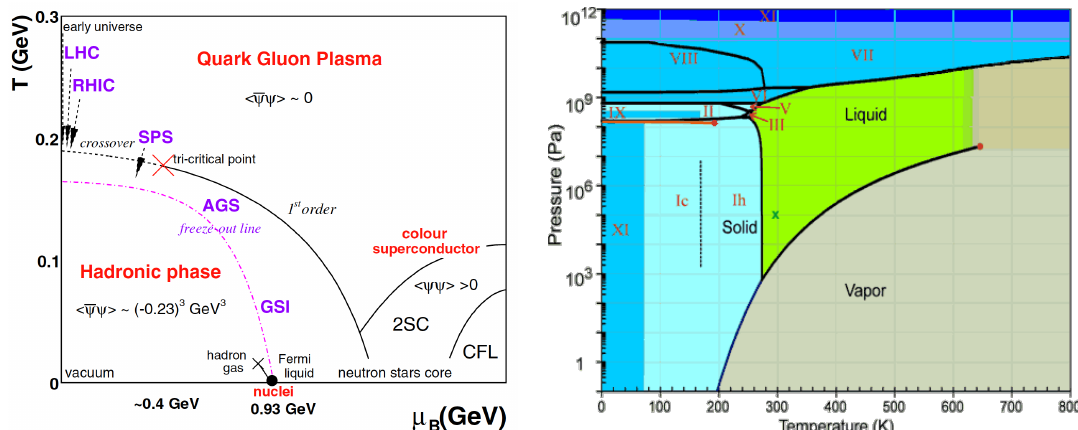
Figure 1. Left : The schematic phase diagram of quantum chromodynamics (QCD) in terms of T and µ B state variables adapted from Ref. [71]; Right : The phase diagram of water illustrates a similar complexity, and is taken from Ref. [72]. AGS: Alternating Gradient Synchrotron; CFL: color–flavor locking; LHC: Large Hadron Collider; RHIC: Relativistic Heavy Ion Collider; SPS: Super Proton